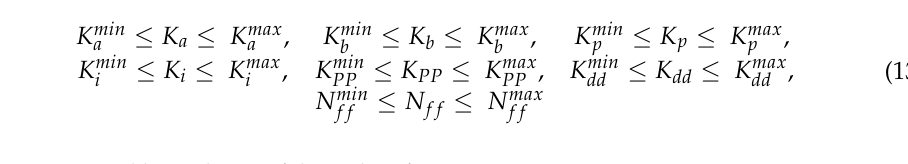
Table 2. Upper and lower limits of the scaling